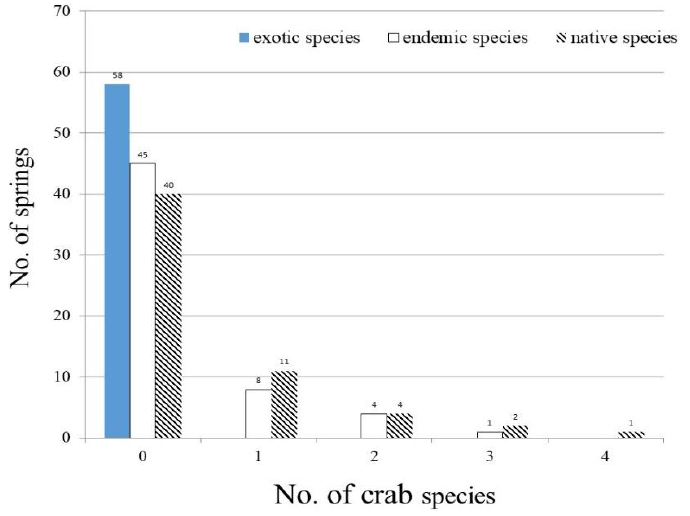
Figure 6. Occurrence frequency of sampled springs for exotic, endemic, and native crab species.